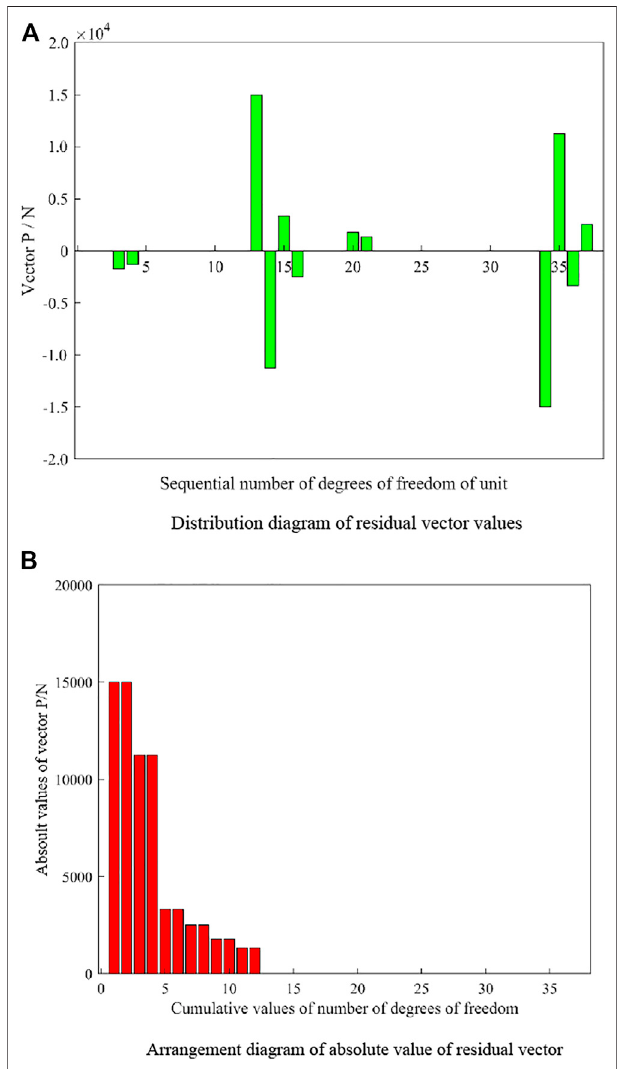
FIGURE 11 | Distribution and arrangement of residual vector values of truss. (A) Distribution diagram of the residual vector values (B) Arrangement diagram of the absolute value of residual vector.